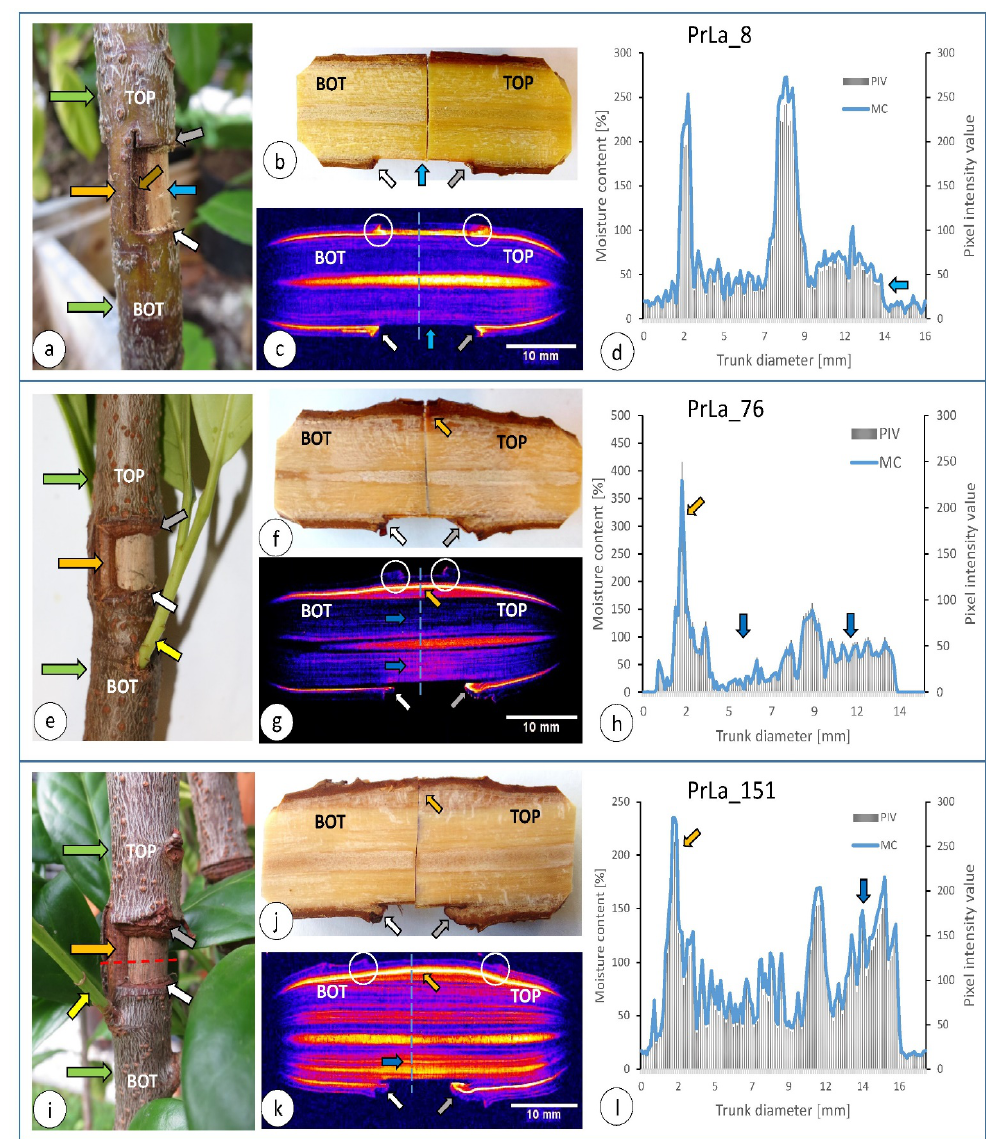
Figure 3. Injured stems of cherry laurel ( Prunus laurocerasus ): ( a , e , i ) situation on the day of sampling; ( b , f , j ) bisected samples on the bottom (BOT) and top (TOP) part; ( d , h , l ) radial profile of moisture content calculated from MRI pixel intensity values, ( c , g , k ) Magnetic Resonance Image (MRI) of injured stems.